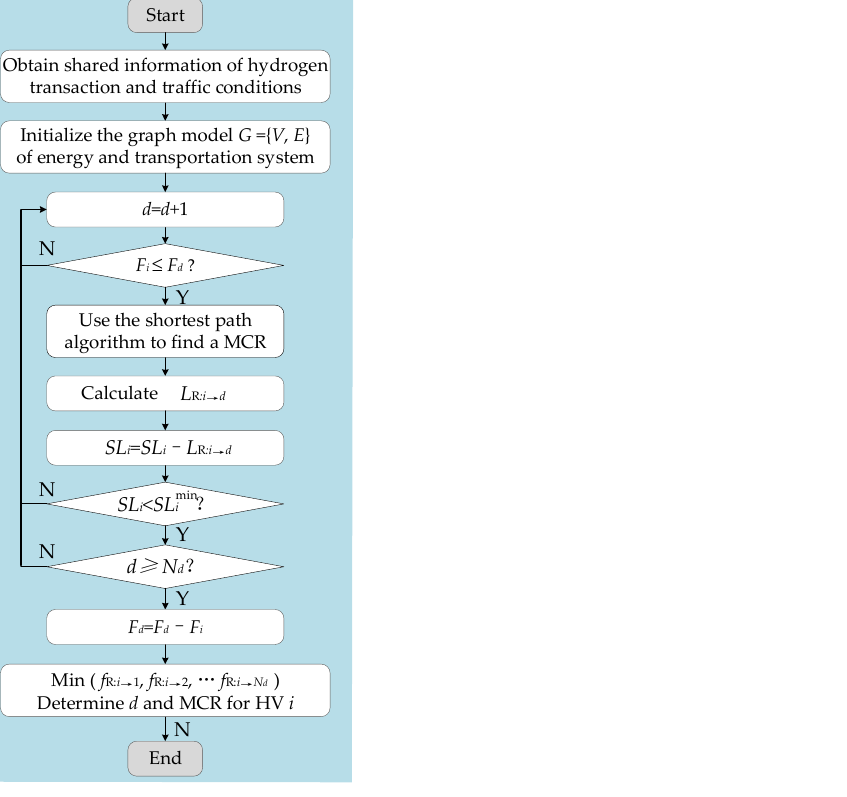
Figure 4. Flowchart of the user-centric routing optimization method. N d represents the total number of candidate DESs.